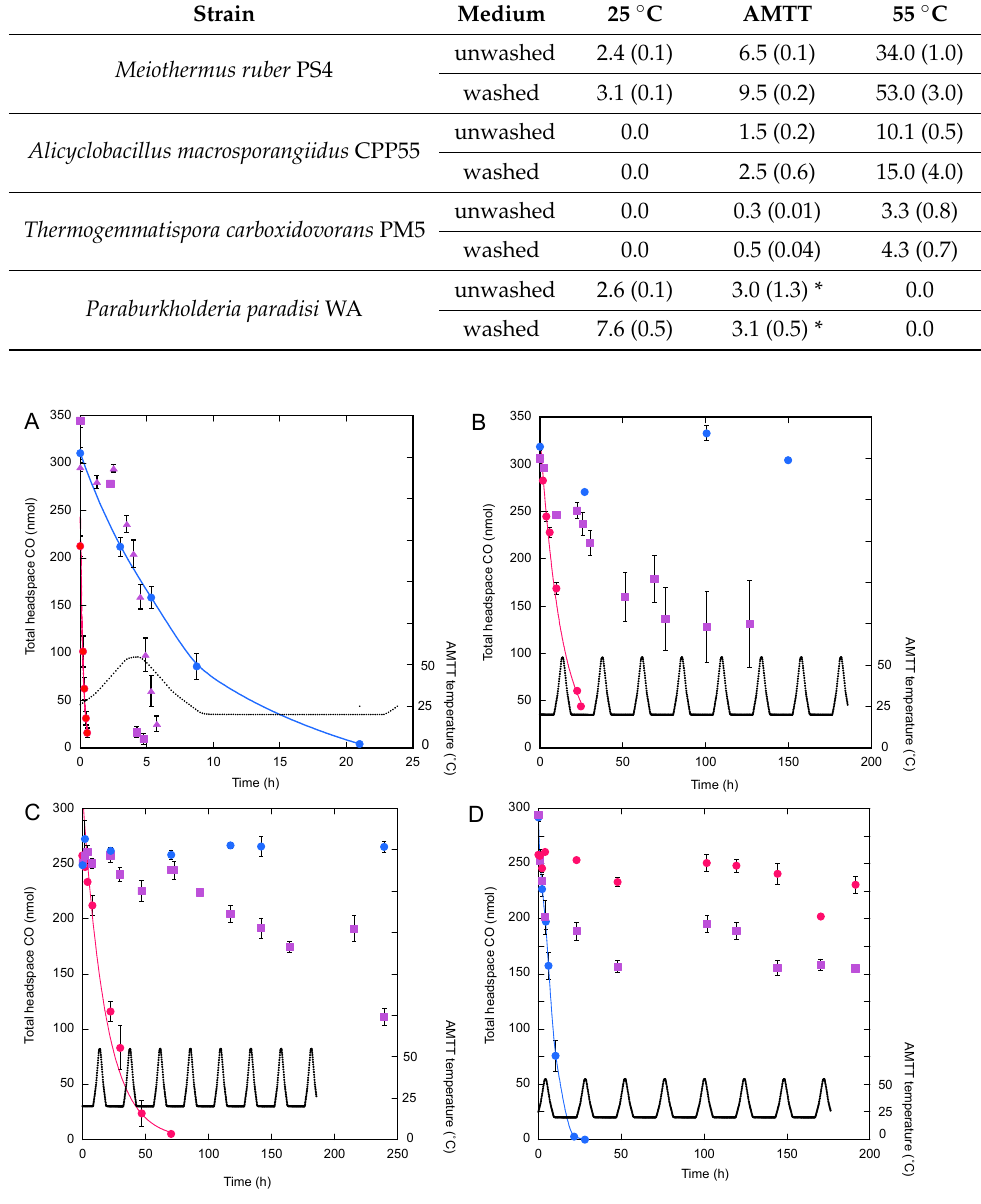
Figure 2. CO uptake by washed cells of Meiothermus ruber PS4 ( A ), Alicyclobacillus macrosporangiidus CPP55 ( B ), Thermogemmatispora carboxidovorans PM5 ( C ) and Paraburkholderia paradisi WA ( D ) at 55 °C (•), with the AMTT regime ( ■ ) or at 25 °C (•). For M . ruber PSR the second CO uptake trial is indicated by ( ▲ ). AMTT temperatures are indicated in black. Data are means of triplicate determinations with ±1 standard error; some error bars are smaller than the symbols.